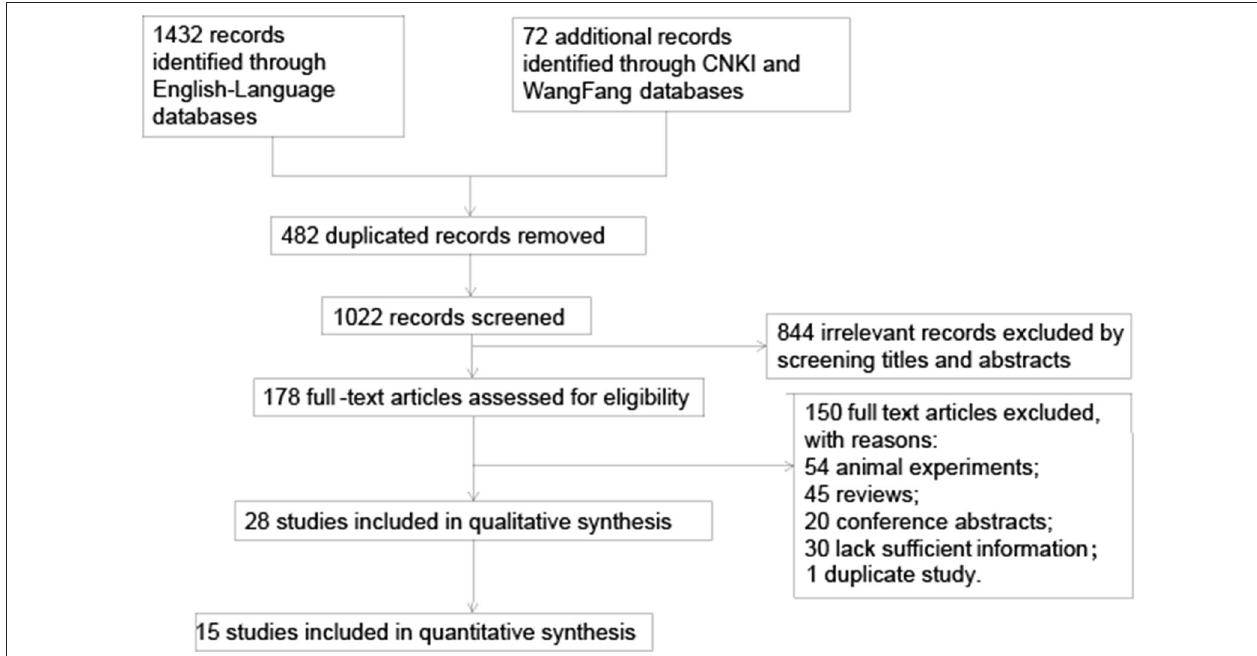
FIGURE 1 | Flowchart of literature search and selection. CNKI, Chinese national knowledge infrastructure; MMP-9, matrix metalloproteinase-9.